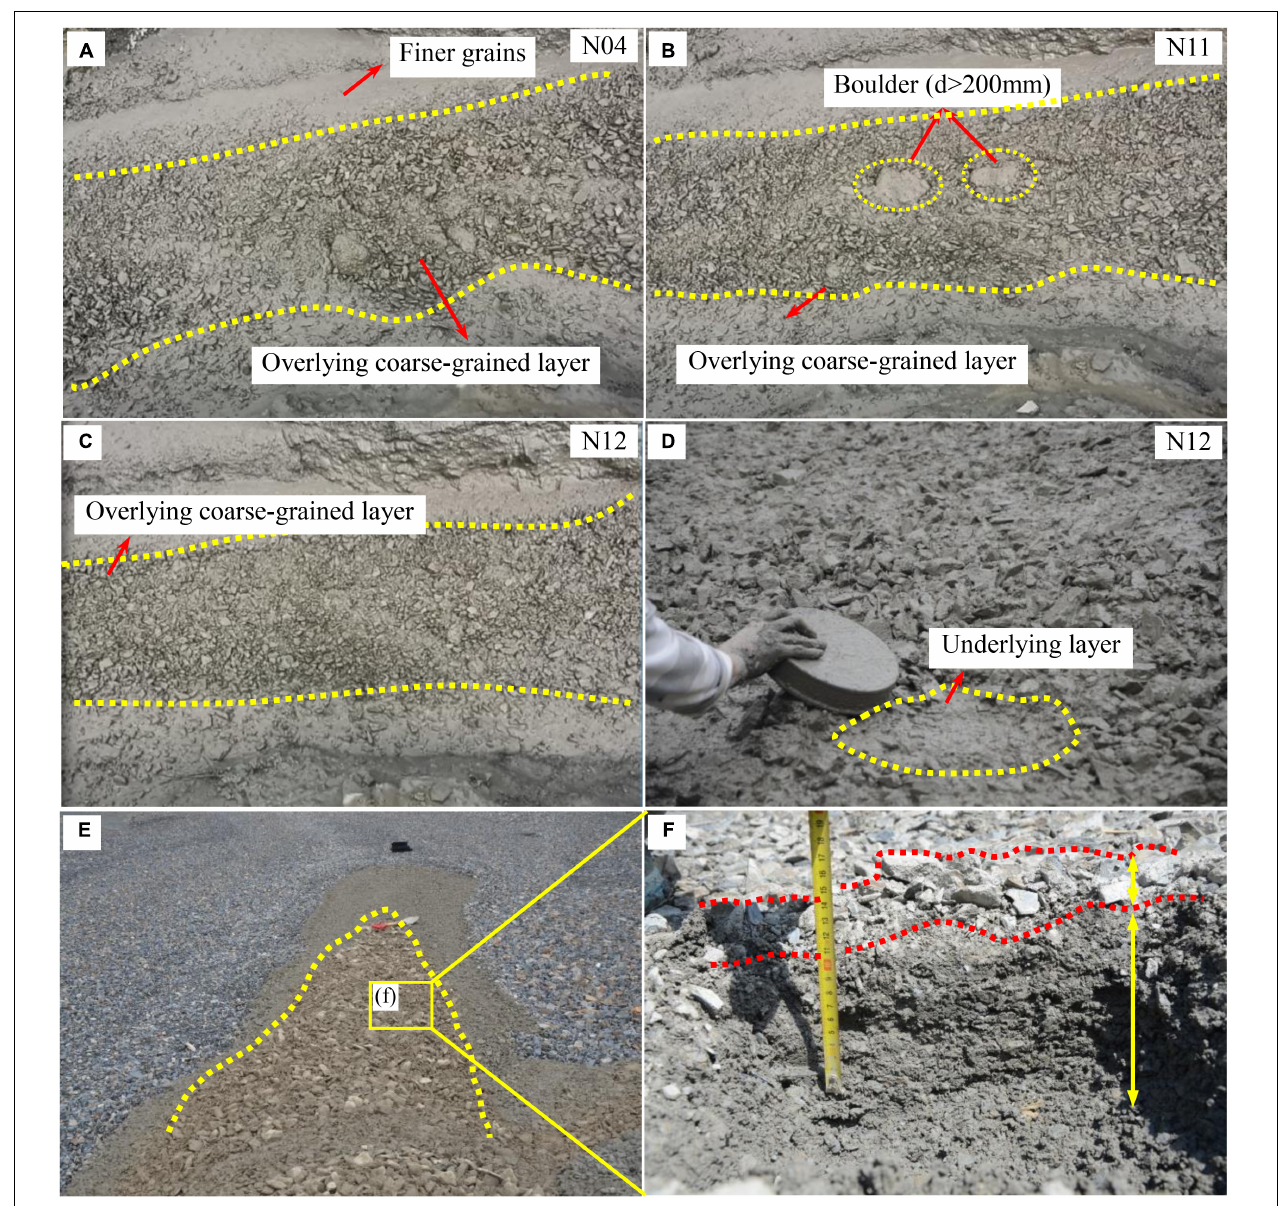
FIGURE 2 | Field investigation; (A) Surge 04, (B) Surge N11, and (C) Surge N12. (D) After the gravels on the surface of surge N04 is dismantled, the underlying layer with finer grains is revealed. (E) Deposition of overlying coarse-grained layer near the tributary gully. (F) Cross section of the rectangular frame in panel (E) , with a depth of 15